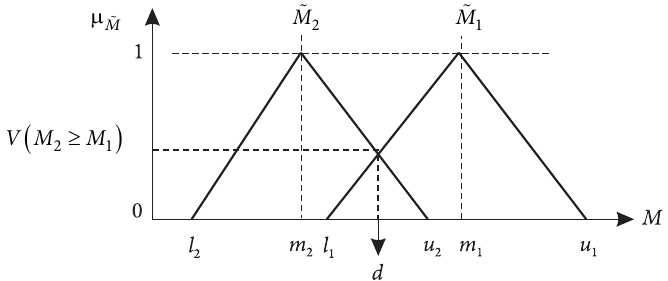
Fig. 1. The intersection between 1 µ and 2